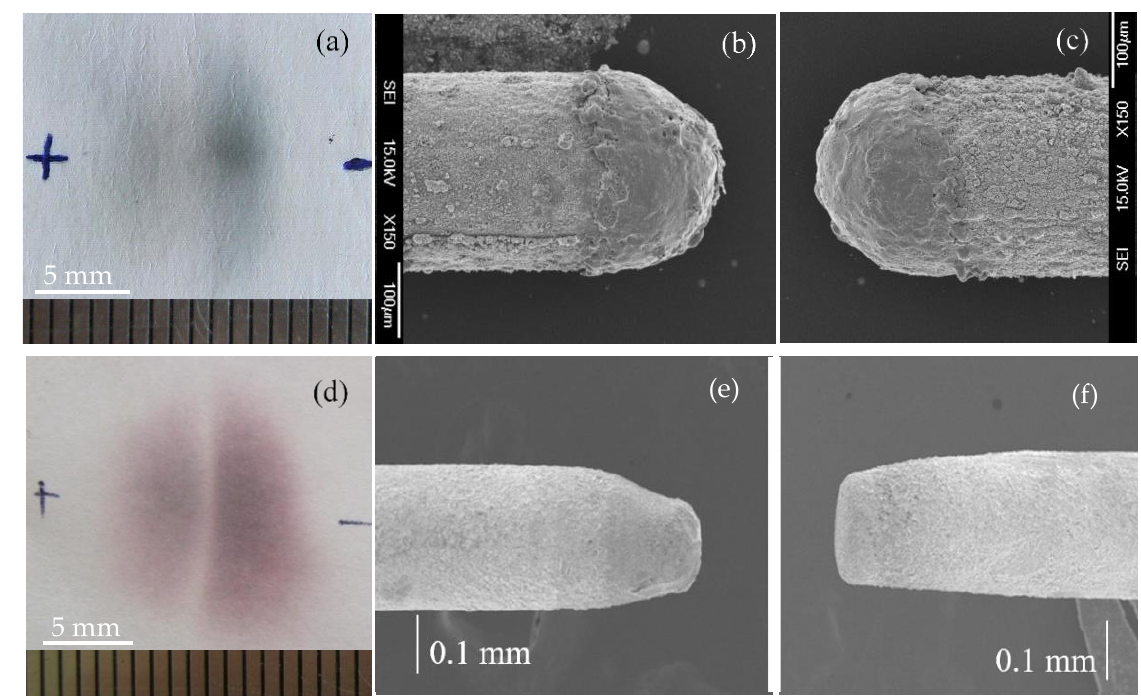
Figure 4. ( a , d ) Nanoparticle films on papers which were placed under the sparking gap of cobalt and gold, respectively. The electrode after 1000 cycles of spark: ( b ) Co-anode ( c ) Co-cathode ( e ) Au-anode and ( f ) Au-cathode.